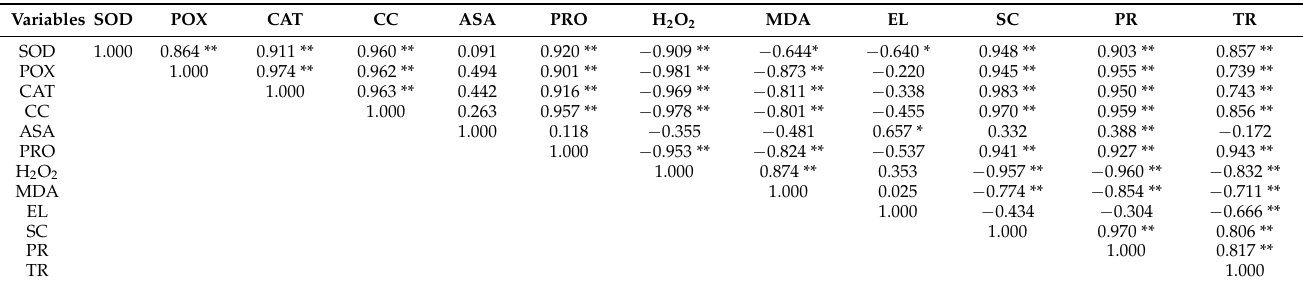
Table 2. Pearson’s product–moment correlation matrix between different physio-biochemical parameters evaluated during the present study.